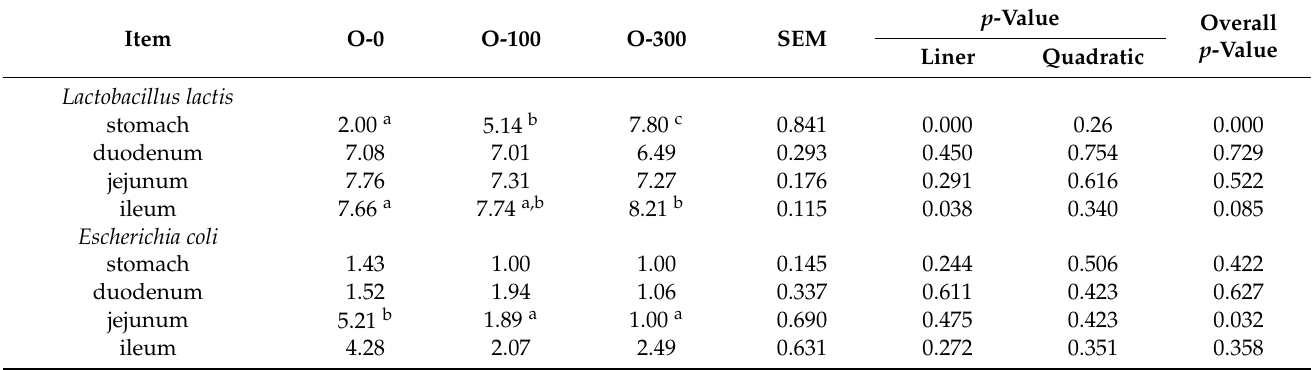
Table 6. Effect of different levels of LL on microbial population (log10 CFU/g fresh chyme) of